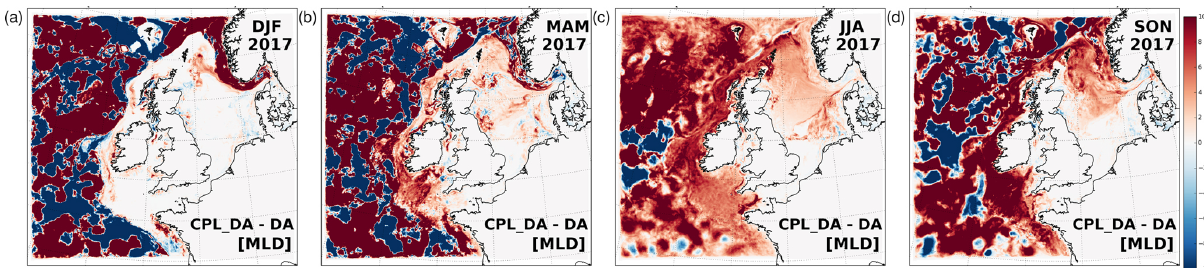
Figure 9. Seasonal mean differences in simulated mixed layer depth (MLD) in CPL_DA relative to DA during